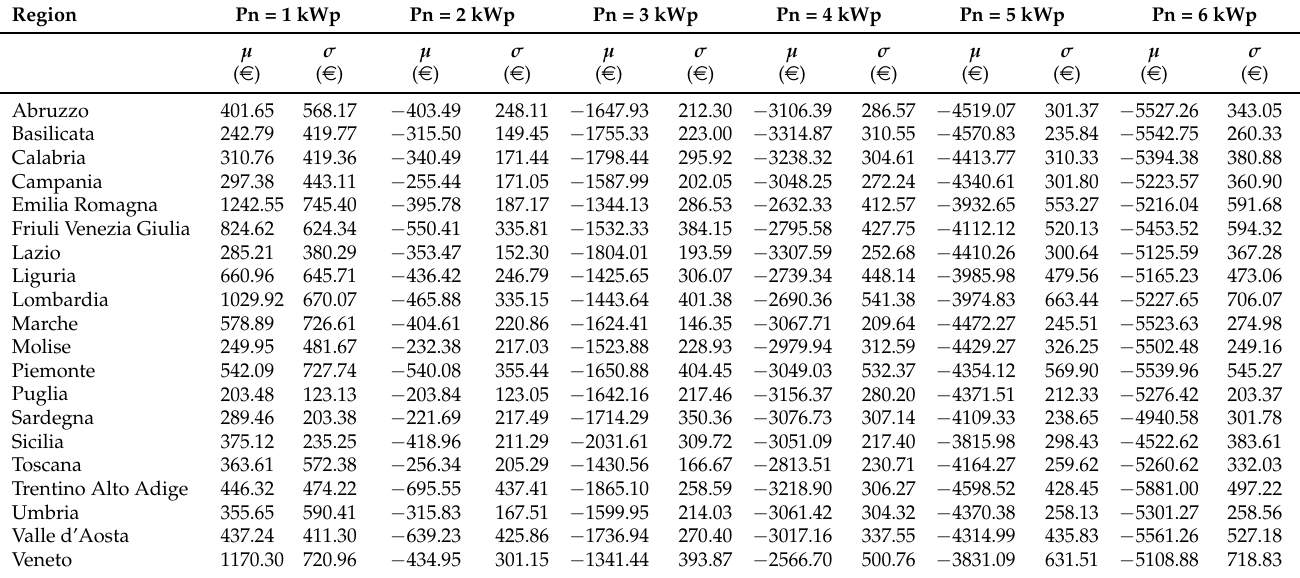
Table 15. NPV for E L = 2700 kWh with